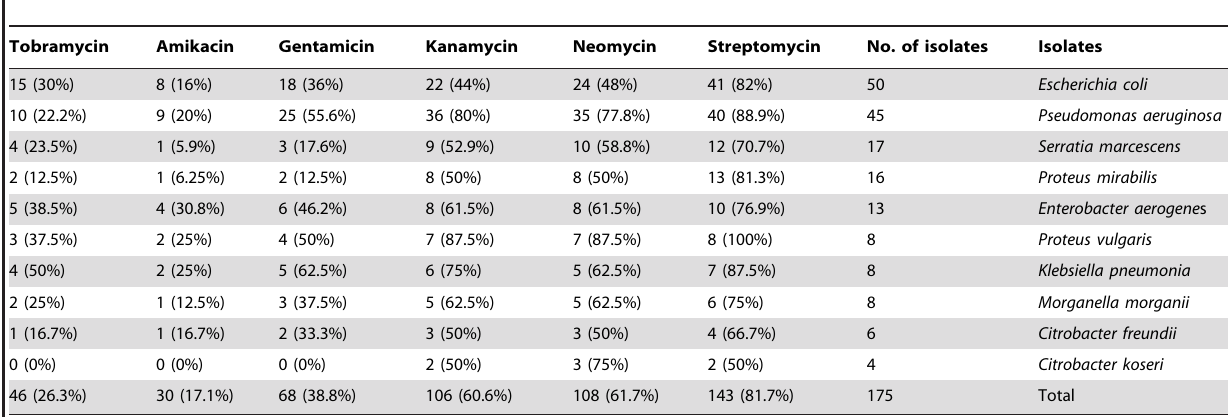
Table 3. Resistance patterns of Gram-negative bacteria to different aminoglycosides (Disk Diffusion method).